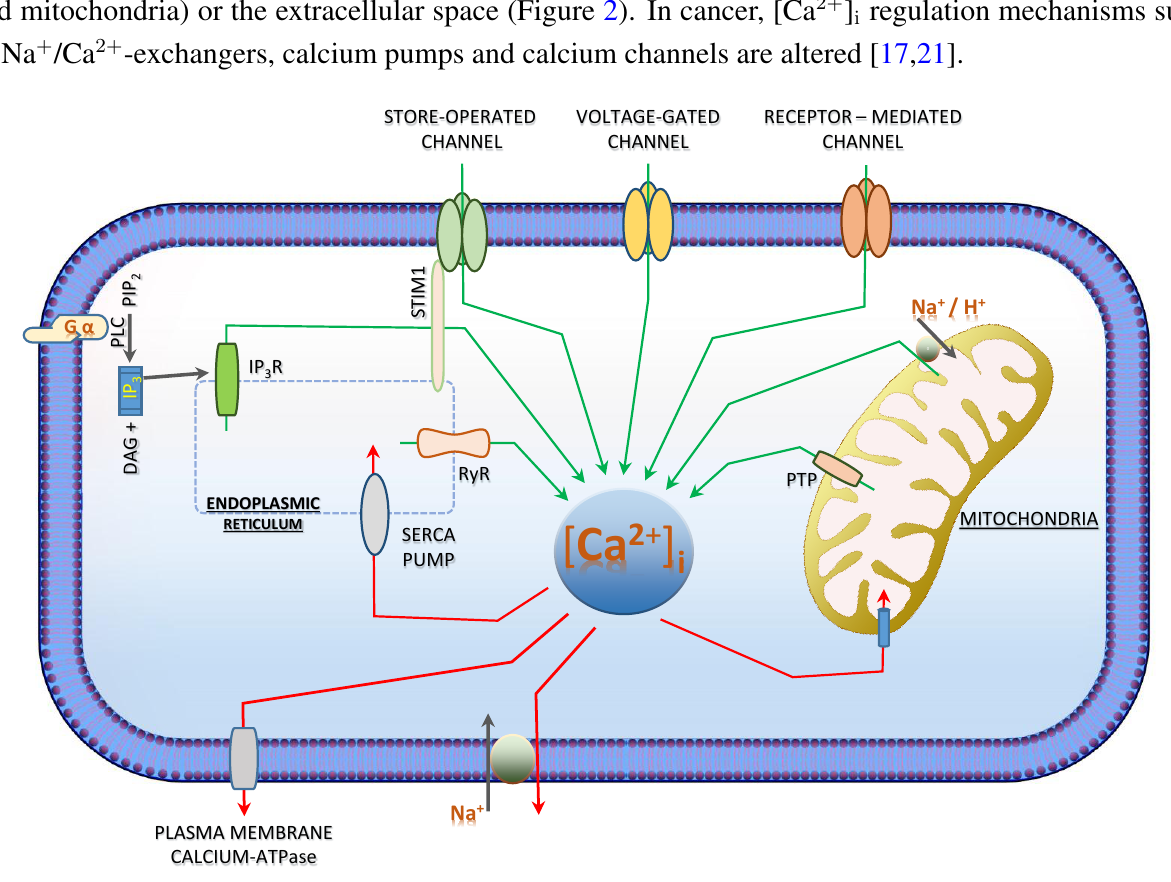
Figure 2. [Ca 2+ ] i -Homeostasis by calcium influx and efflux: Intracellular calcium increases (green arrows) via the (1) voltage-gated channels, (2) receptor-mediated channels, (3) Na 2+ /Ca 2+ and Na 2+ /H + -Exchangers (4) store-operated channels which includes the IP 3 R and RYR (5) GPCR activated IP 3 R activation. [Ca 2+ ] i decreases (red arrows) via the (1) SERCA pump, (2) plasma membrane calcium ATPase pump (PMCA), (3) permeability transition pore (PTP) and (4) Na 2+ /Ca 2+ Exchangers. In neuroblastoma, receptor